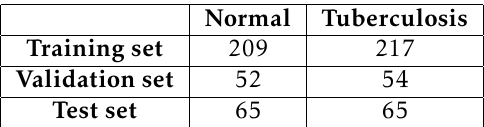
Table 2. Details about how Shenzhen dataset is splitted